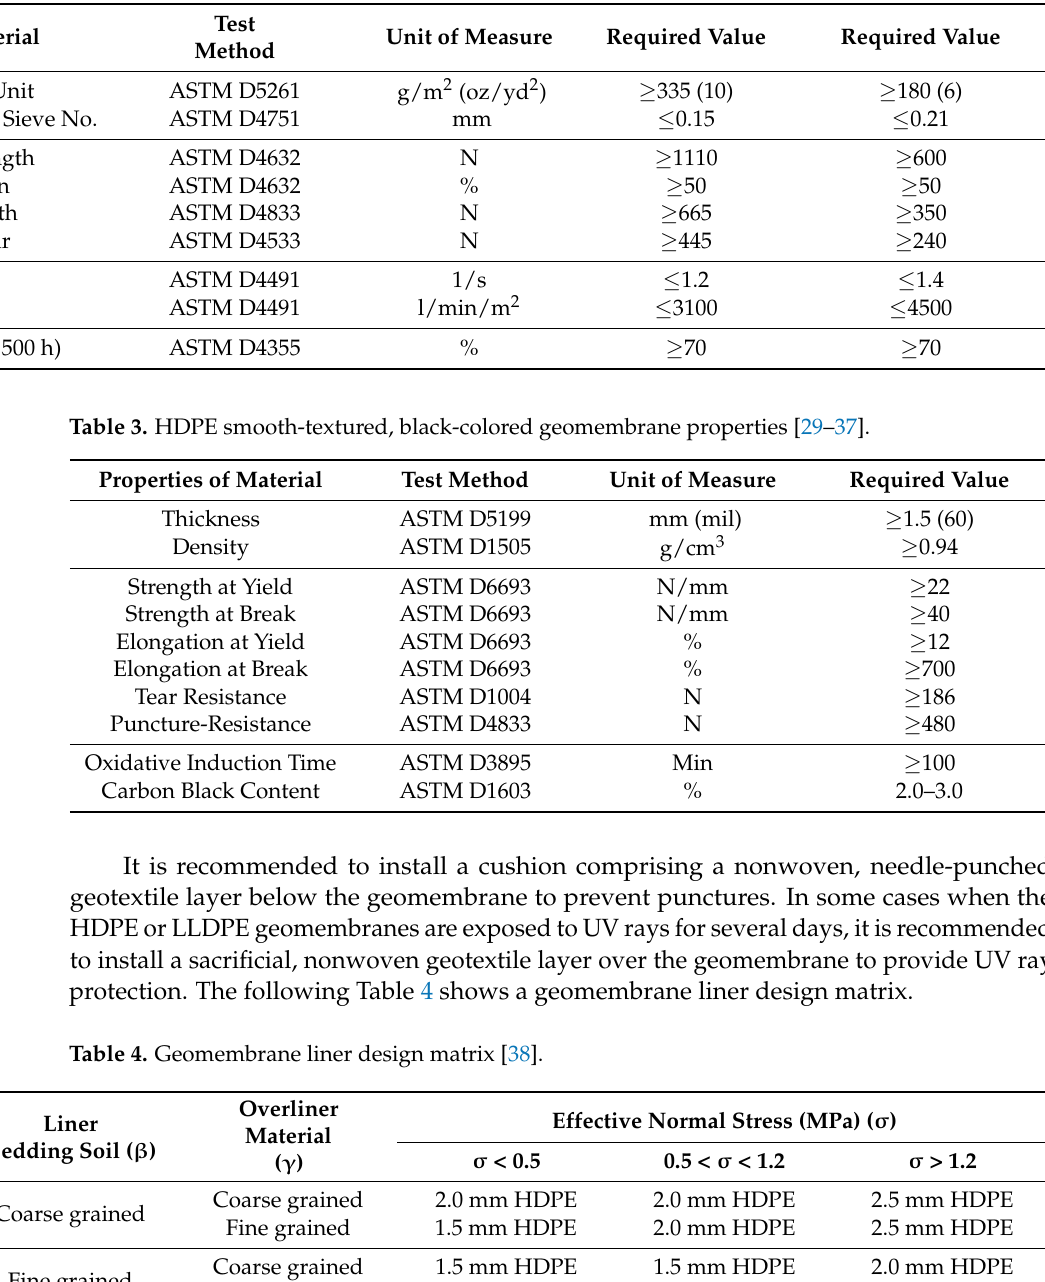
Table 2. Nonwoven, needle-punched geotextile properties [29–37].